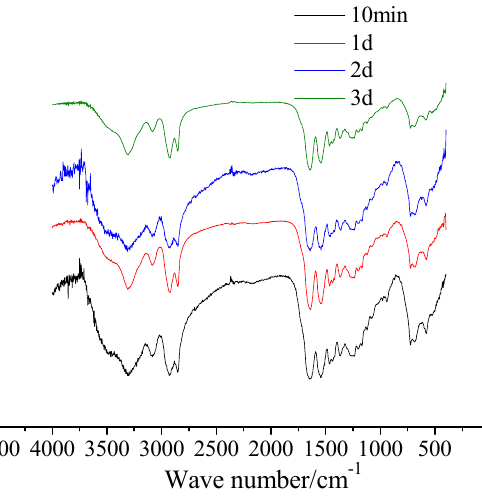
Figure 3. Fourier transform infrared spectra (FTIR) spectra of HMP heated at 160 °C for 10 min, one day, two days and three days.